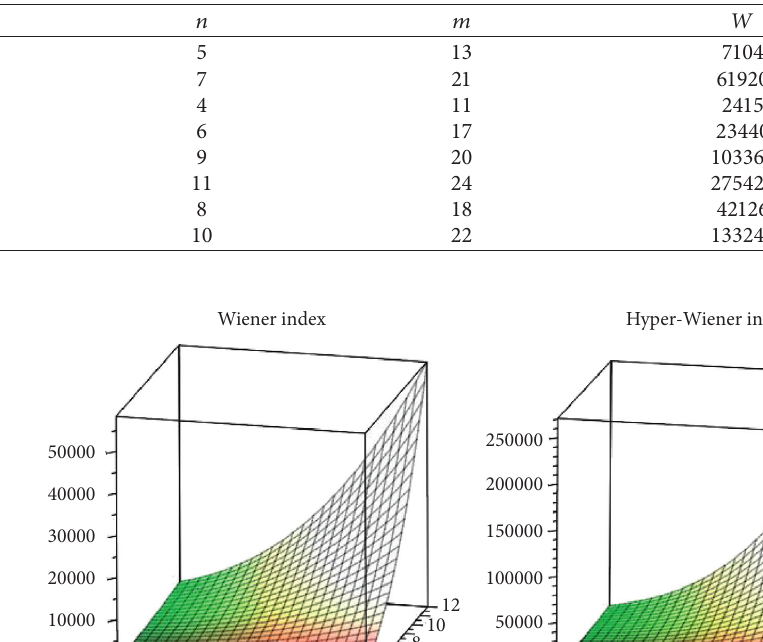
Table 2: Wiener and hyper-Wiener indices of the